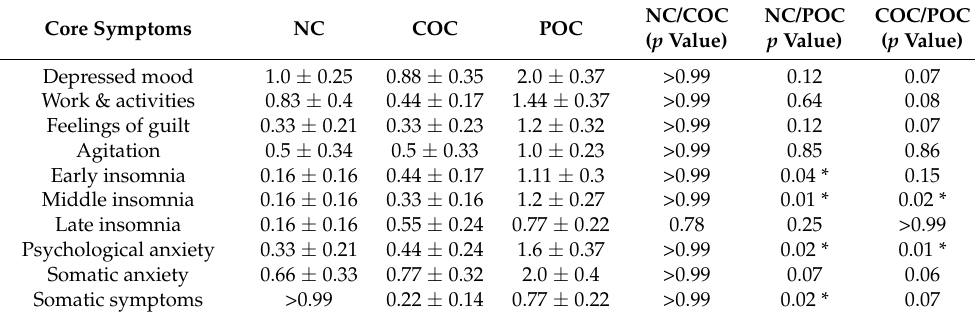
Table 2. Core symptoms of depression on the HAM-D scale (mean ± SEM).